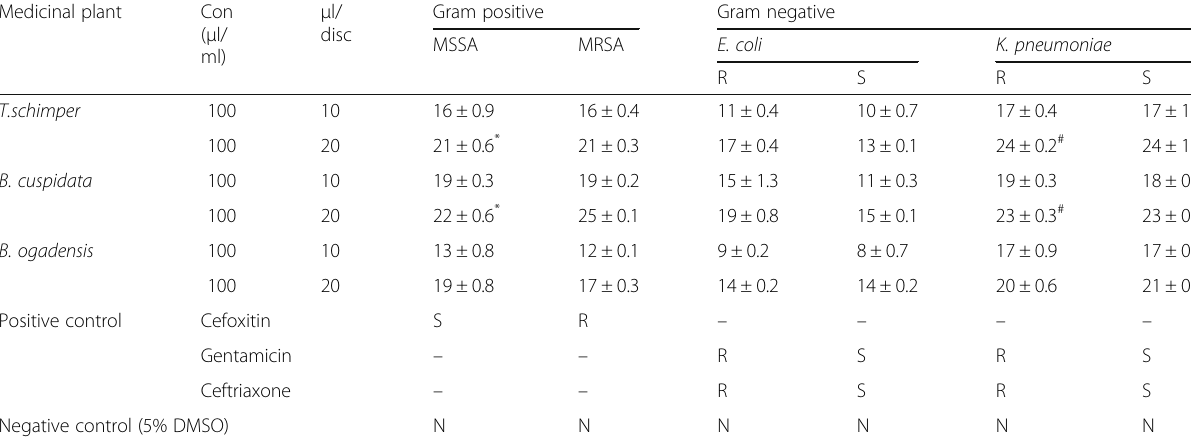
Table 2 Inhibition zone (mm) of essential oils against MDR bacteria at AAU, 2018 Medicinal plant